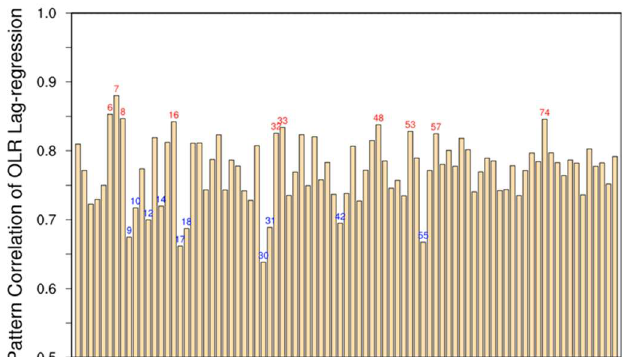
Figure 1. Scores of 85 integrations by Lag-correlation defined as the average values of two pattern correlation correlations (PCCs) in each run. The PCCs of each run are computed between the Hovmöller diagrams in it and observation, which are given by averaging equatorial (10° S–10° N; 60° E–180°) lag regressed 20-100 day filtered outgoing longwave radiation (OLR) from day −20 to 20 against the area-averaged time series of itself over India (5° S–5° N; 75° E–85° E) and Pacific (5° S–5° N; 130° E–150° E). The highest (lowest) 10 runs are labeled with their experiment identification number in red (blue).